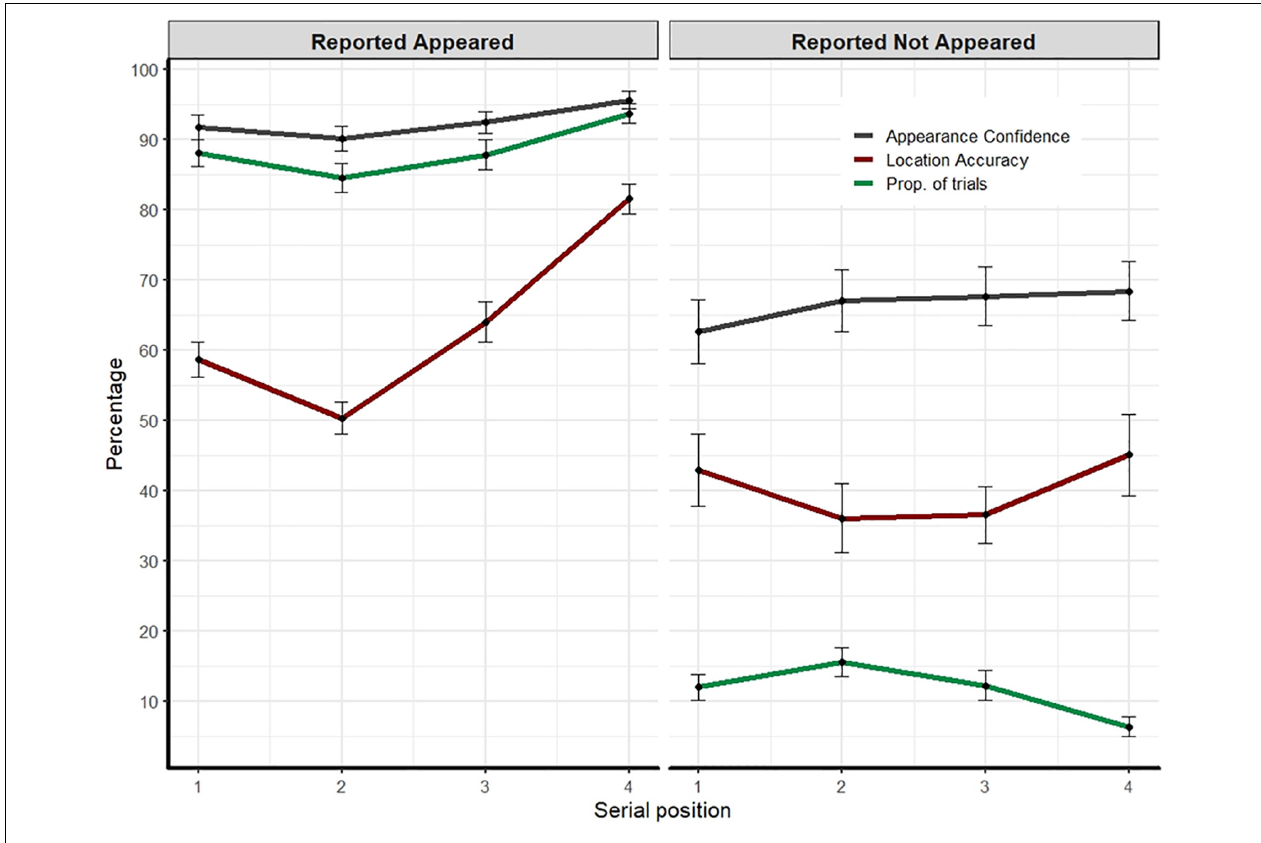
FIGURE 3 | Experiment’s 2 results: Appearance confidence, mean correct location responses, and the proportion of trials as a function of participants’ appearance report (i.e., appear, did not appear) and the item’s serial position. Error bars represent one standard error of the mean.